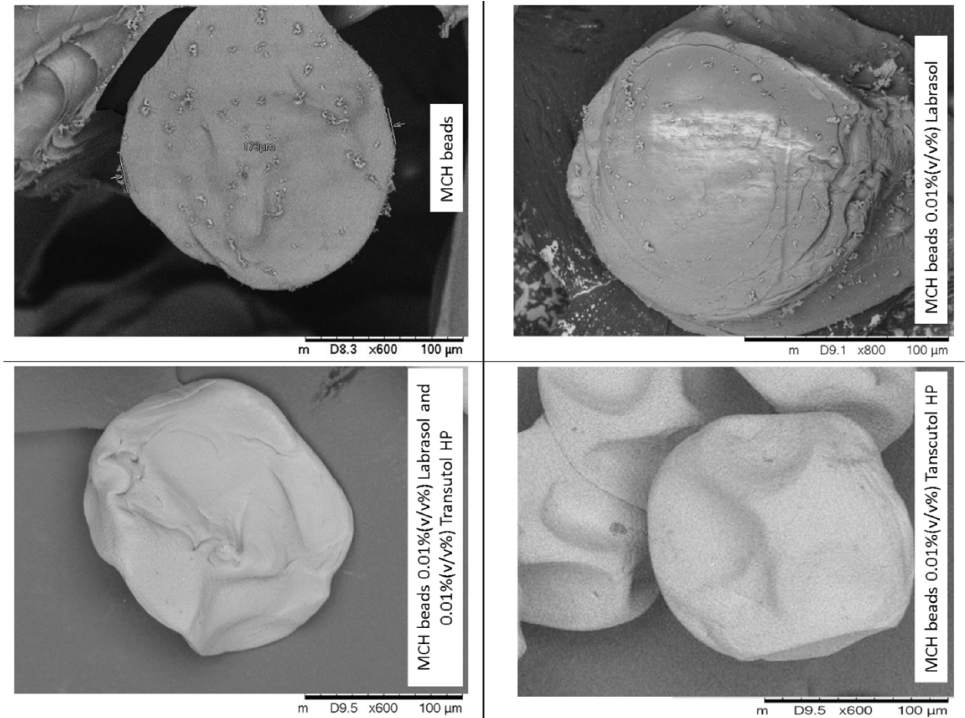
Figure 3. Scanning electron microscopy images of the different formulated sodium-alginate beads containing MCH. During the drying process some squashes occurred on the bead surface.